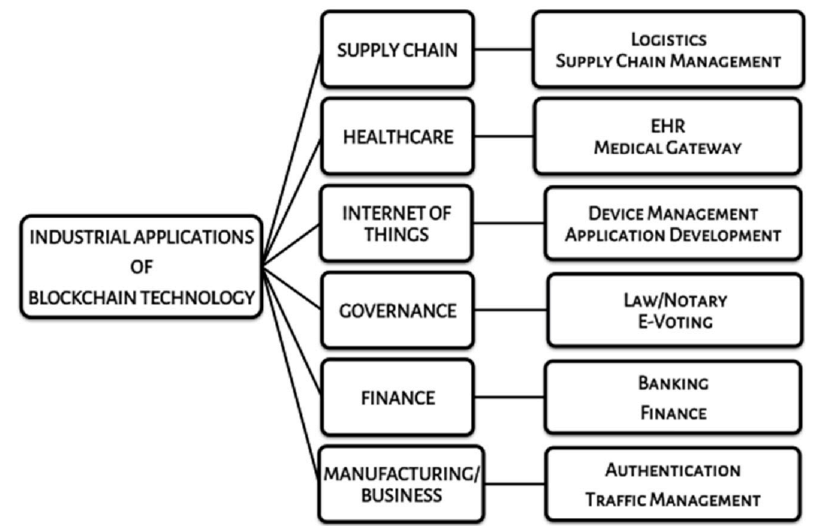
Figure 8. Some of the Industrial Applications of Blockchain